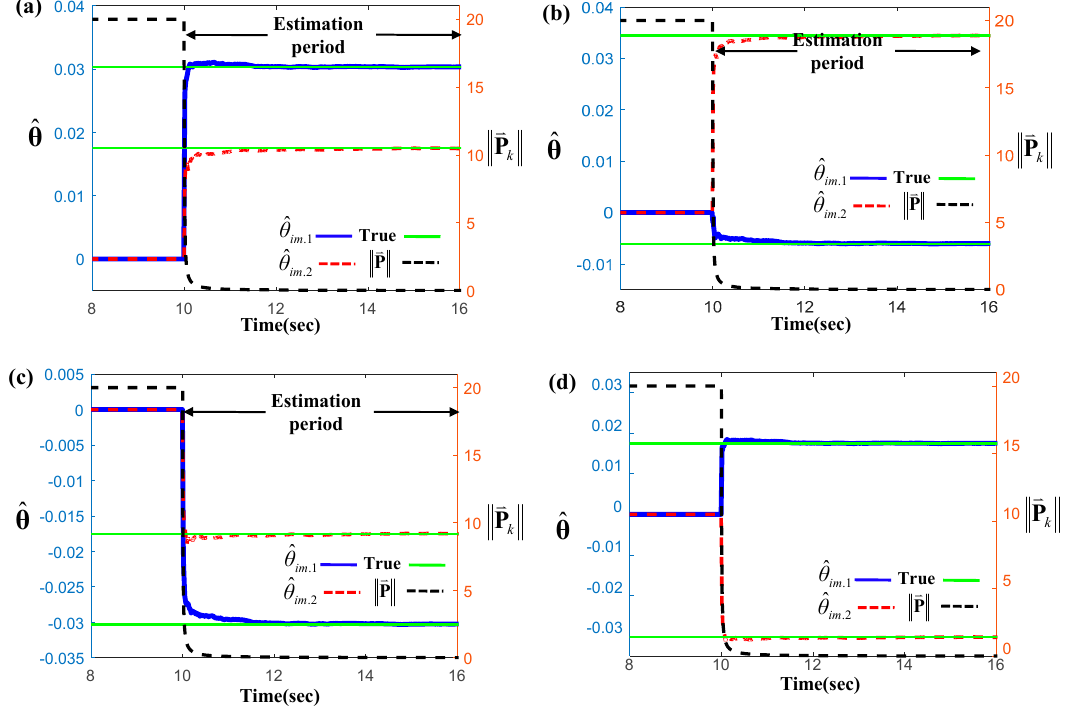
Figure 4. Estimations of the four di ff erent imbalances θ = [ ˆ θ im .1 ˆ θ im .2 ] T (( a ) result for φ im = 30 ◦ , ( b